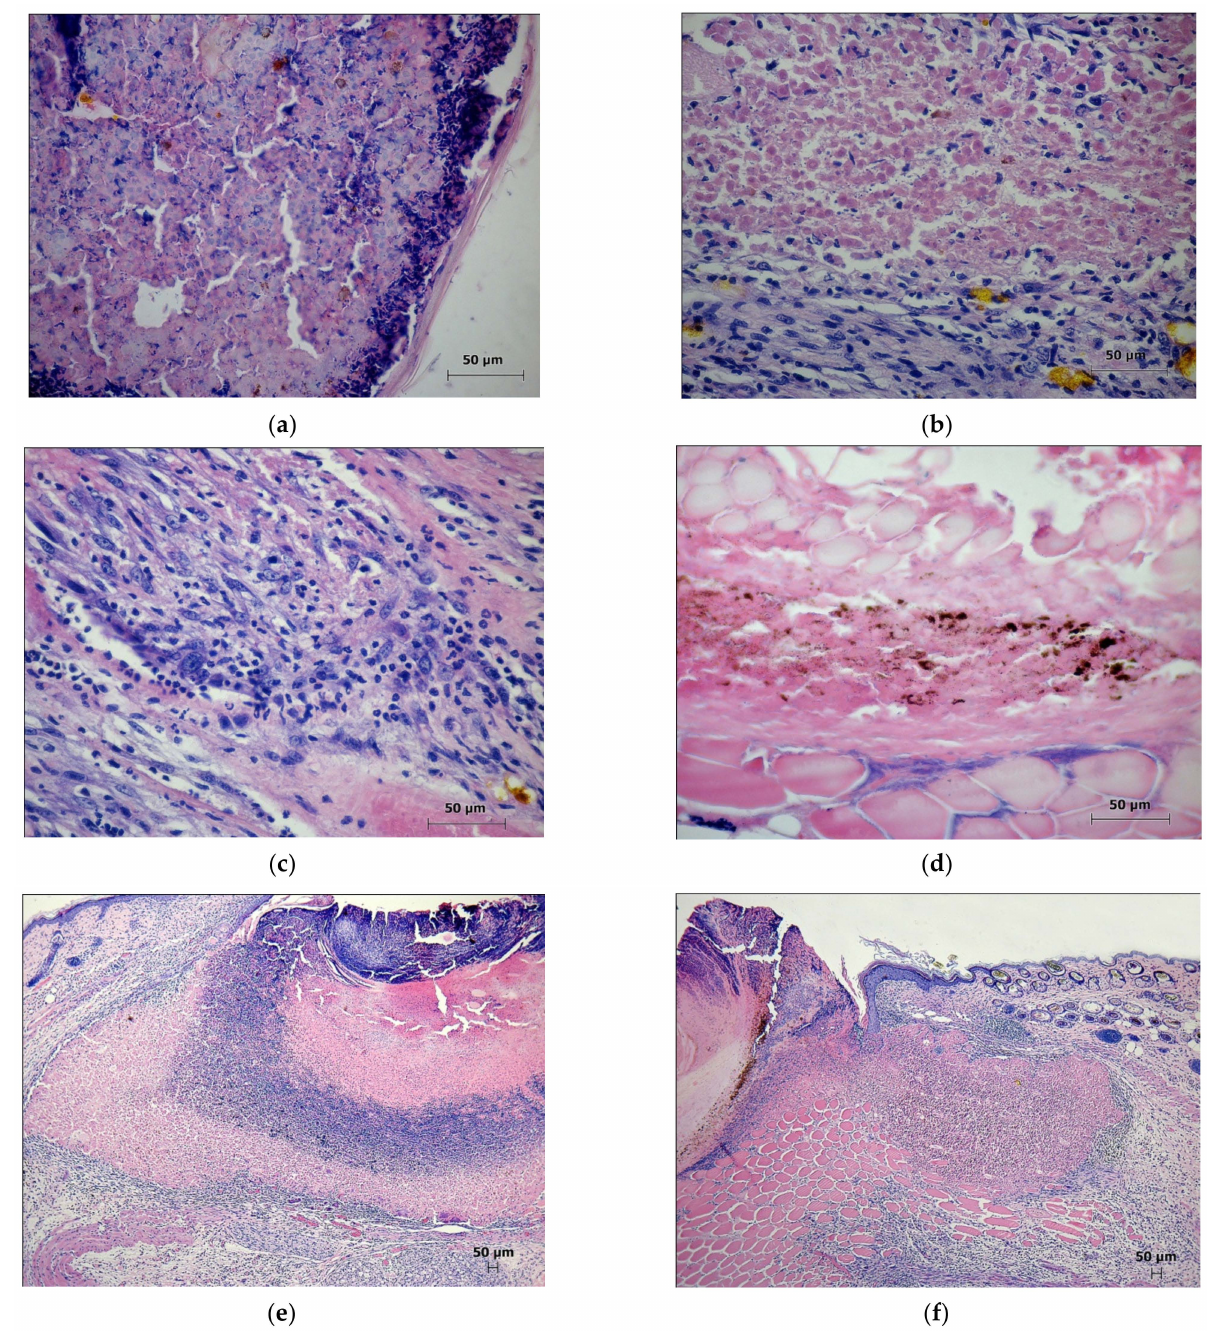
Figure 8. The zone of the laser exposure on the 21st day after the PDT. Experimental group 4: ( a ) Fragment. The histostructure of a necrotic tumor removed as a part of a detached scab. Staining with hematoxylin and eosin. × 40; ( b ) Fragment. A fragment of a necrotic tumor preserved in the PDT zone. Staining with hematoxylin and eosin. × 40; ( c ) Fragment. The microsection of a necrotic tumor containing viable B16 melanoma cells. Staining with hematoxylin and eosin. × 40; ( d ) The eschar in the PDT zone containing a necrotic tumor after the photodynamic exposure. Staining with hematoxylin and eosin. × 40; ( e ) Fragment. A part of a necrotic tumor limited by a leukocyte wall and located as a part of a developing scab in the PDT zone. Staining with hematoxylin and eosin. × 5; ( f ) Fragment. A part of an unremoved necrotic tumor located under the skin regenerated after the photodynamic exposure. Staining with hematoxylin and eosin. ×